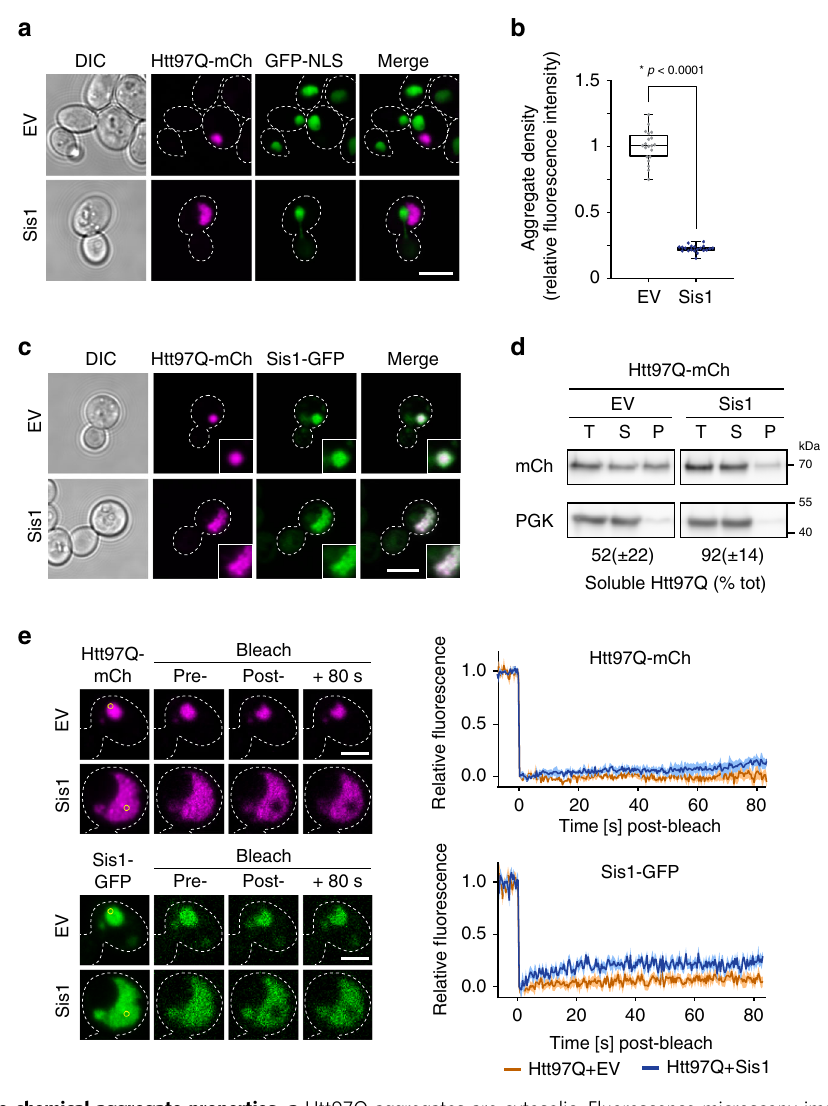
Fig. 3 Sis1 affects physico-chemical aggregate properties. a Htt97Q aggregates are cytosolic. Fluorescence microscopy images of cells expressing Htt97Q-mCherry without or with Sis1 overexpression. Confocal microscopy was performed on cells expressing NLS-GFP as nuclear marker. Scale bar = 5 μ m. Experiments were performed in triplicate, representative images shown. b Htt97Q aggregates in Sis1 overexpressing cells are less dense. The average fl uorescence intensity of aggregates from cells without or with Sis1 overexpression was measured using confocal microscopy. Box plots represent median and 25th and 75th percentile, and whiskers minimal and maximal values. n = 20 cells, * p < 0.0001 by unpaired, two-sided t -test. c Sis1 co-localizes with Htt97Q. Confocal images of cells containing endogenously tagged Sis1-GFP and expressing Htt97Q with or without Sis1 overexpression as in Fig. 2. Representative images are shown, scale bar = 5 μ m. Experiments were performed in triplicate, representative images shown. See also Supplementary Fig. 3a. d Increased solubility of Htt97Q in Sis1 overexpressing cells. The fraction of soluble material was analyzed in cell lysates fractionated into total (T), soluble (S) and pellet (P) fractions by centrifugation and analyzed by immunoblotting for mCherry (Htt97Q) and for PGK as loading control (see “ Methods ” section for details). Data were quanti fi ed by densitometry. Data represent mean ± SD from three independent experiments. e Htt97Q and Sis1 are immobile within inclusions. Htt97Q-mCherry (top) or endogenously tagged Sis1-GFP (bottom) were analyzed by fl uorescence recovery after photo bleaching (FRAP) in cells expressing Htt97Q-mCherry with or without Sis1 overexpression. Representative images pre- and post-bleach are shown on the left, scale bar = 2.5 μ m. Mean (solid lines) ± SE (traces) of fl uorescence recovery of at least three experimental replicates are shown on the right. See Supplementary Fig. 3b for Htt20Q-mCherry